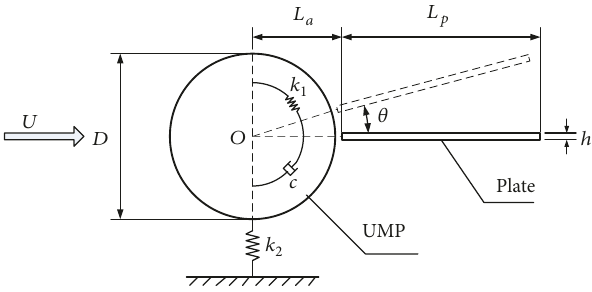
Figure 2: A simplified 2D model of UMP with a splitter plate.